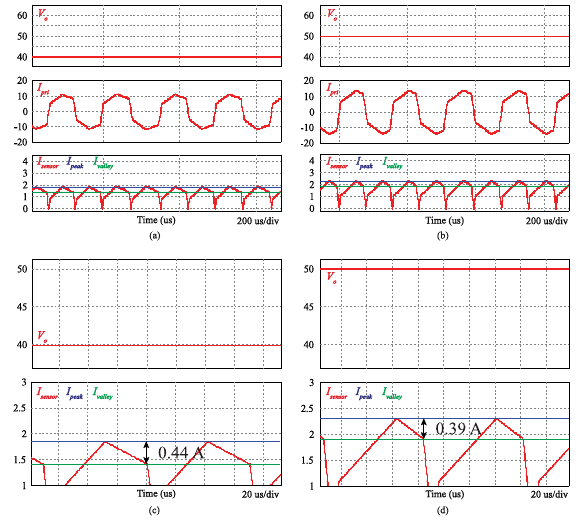
Figure 16. Simulated current waveforms of the proposed HCMC according to output voltages: